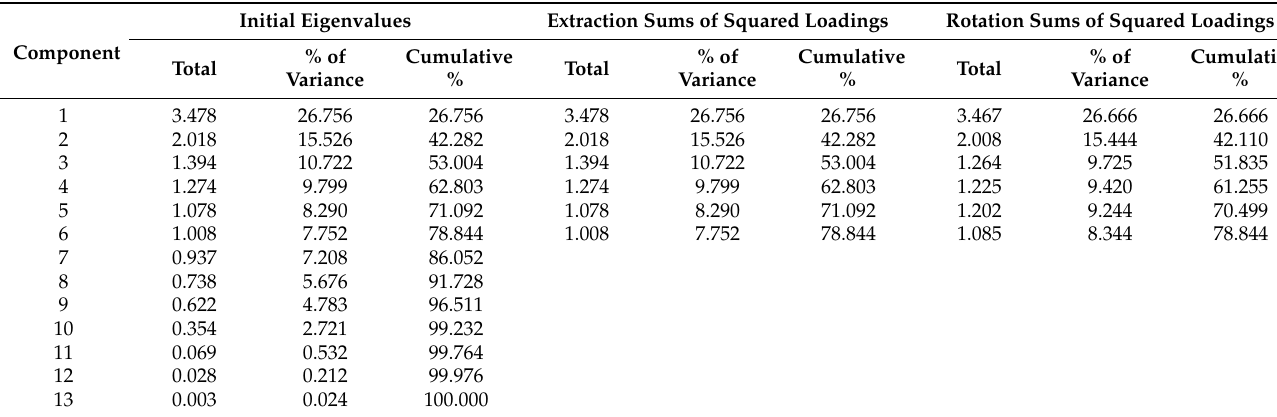
Table 7. Total variance explained.